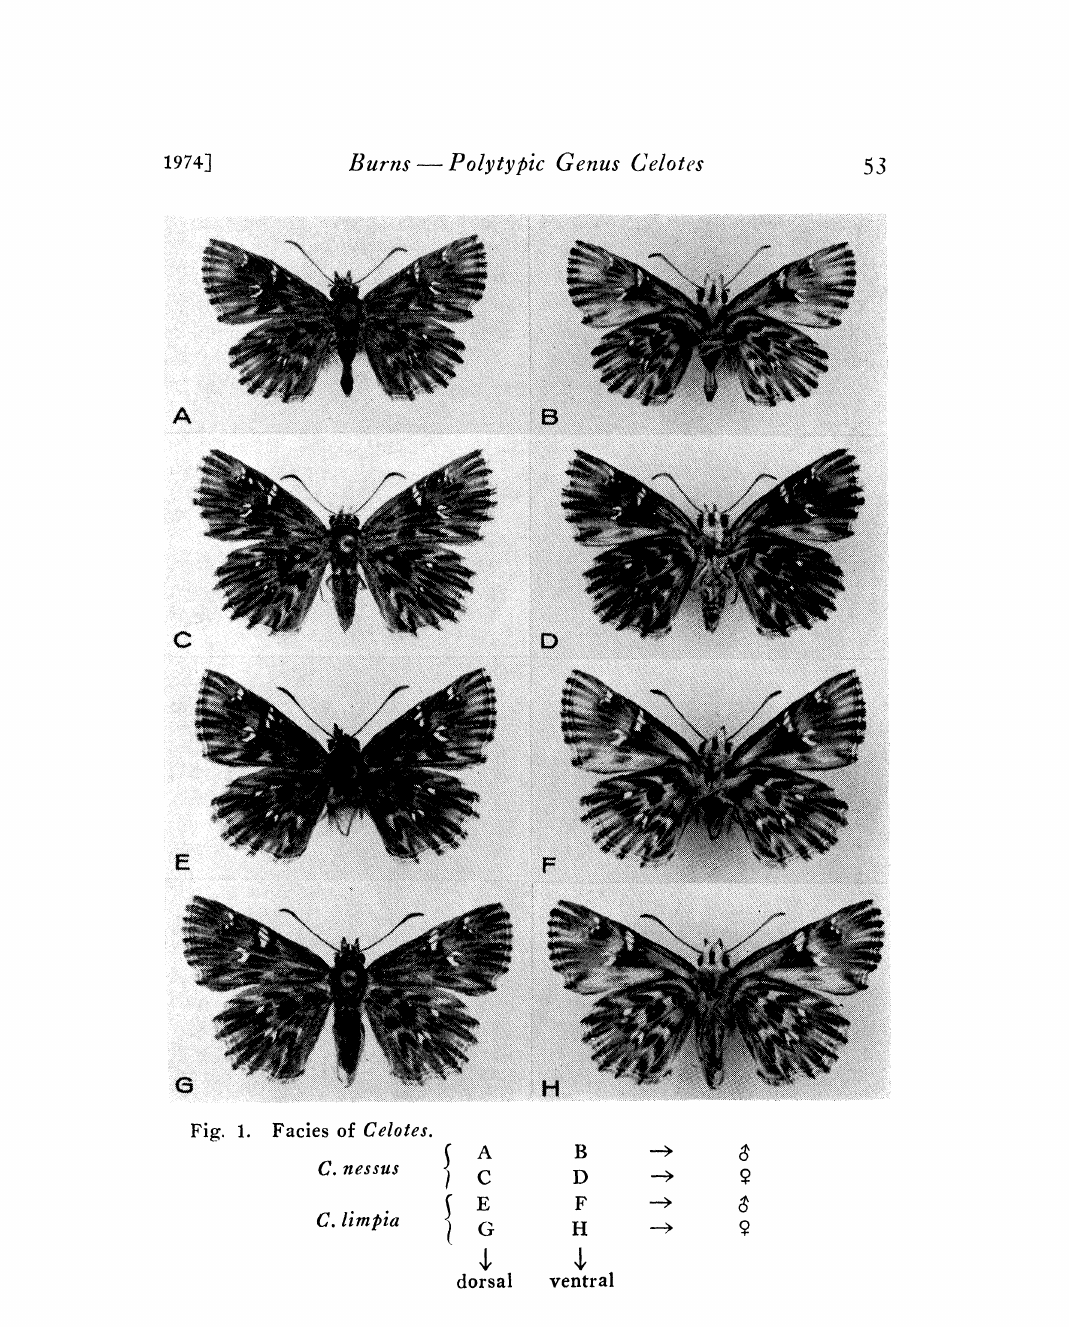
Fig. 1. Facies of